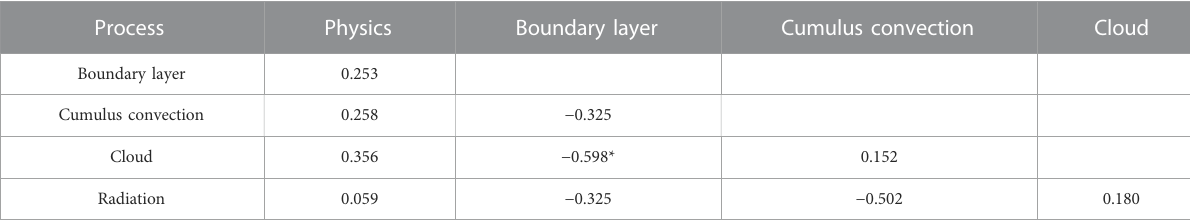
TABLE 3 Correlation coef fi cients of the temperature tendencies for each process in the summer.